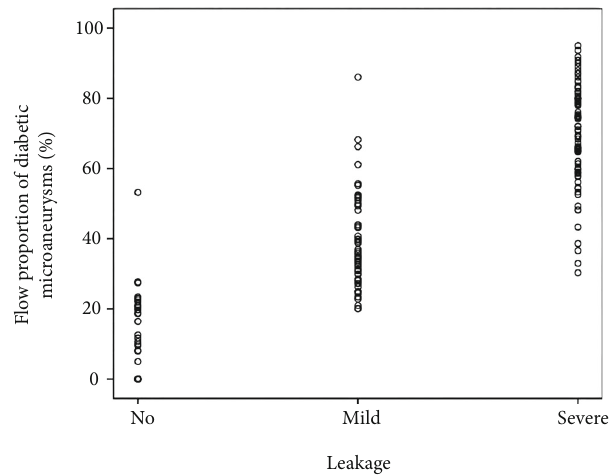
Figure 7: Scatter plot of fl ow proportion of diabetic microaneurysms in di ff erent fl uorescein leakage groups.